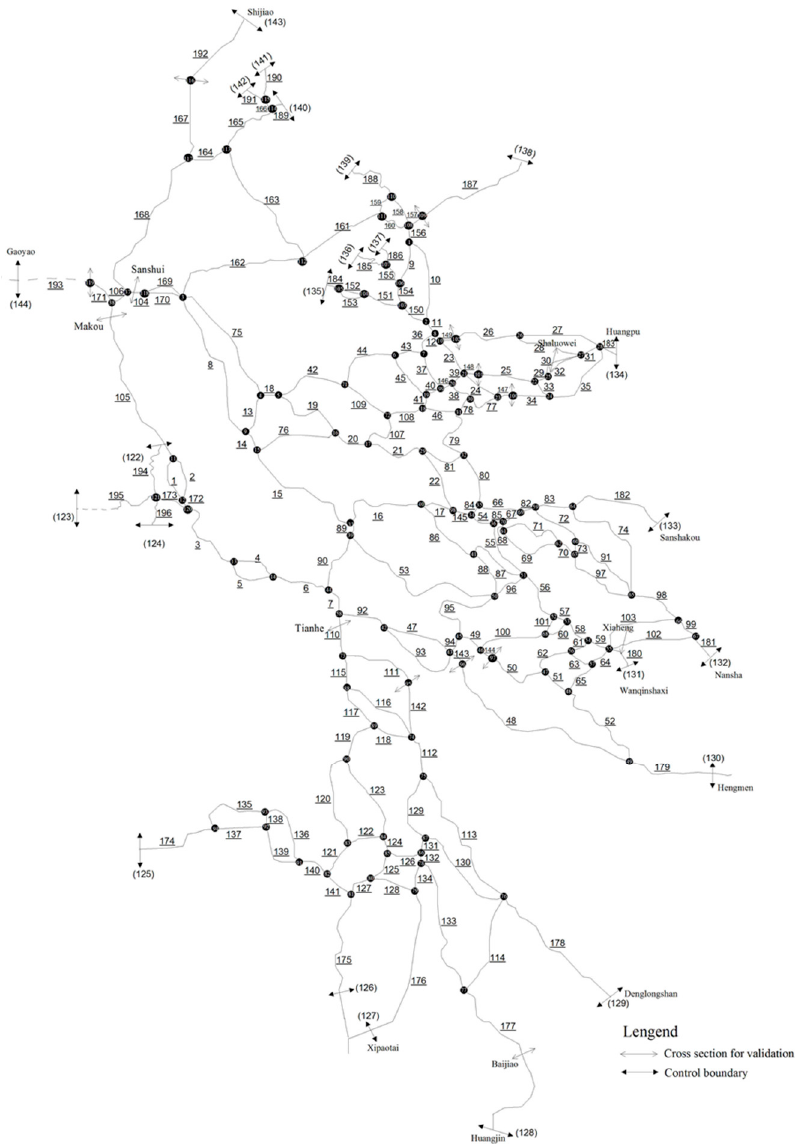
Figure 3. Overview of the simplified one-dimensional hydrodynamic model of PRD.